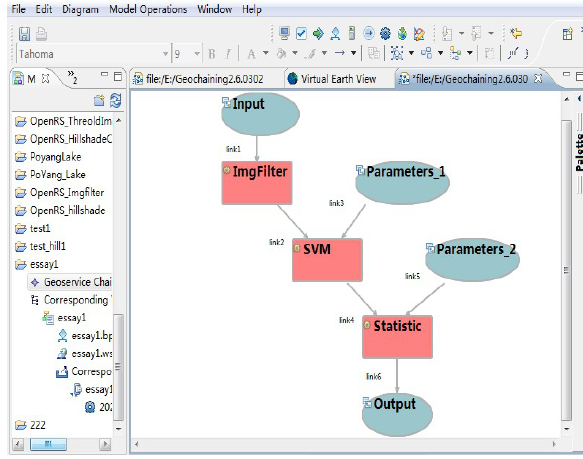
Figure 2. Geospatial Web Services Composition Model